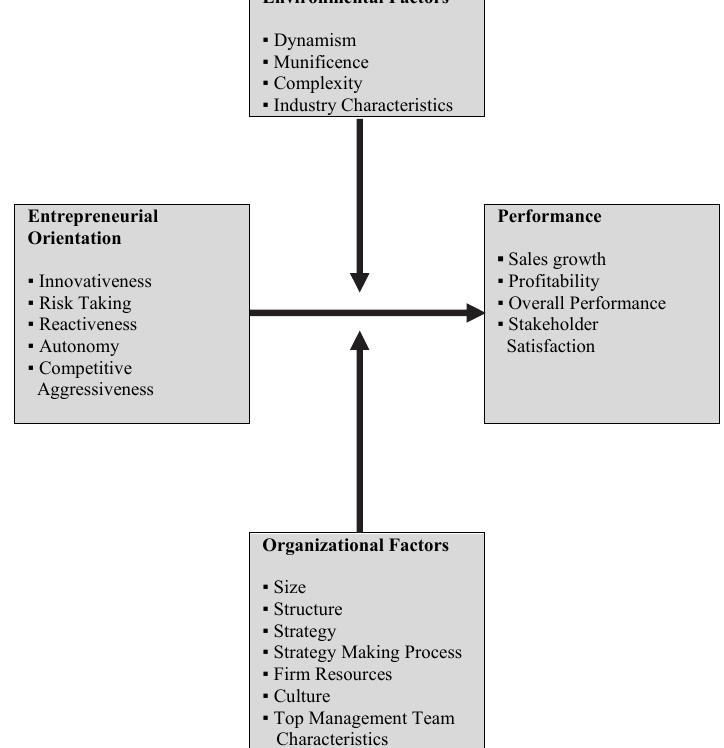
Fig. 2. Framework of Entrepreneurial Orientation Source: Lumpkin and Dess